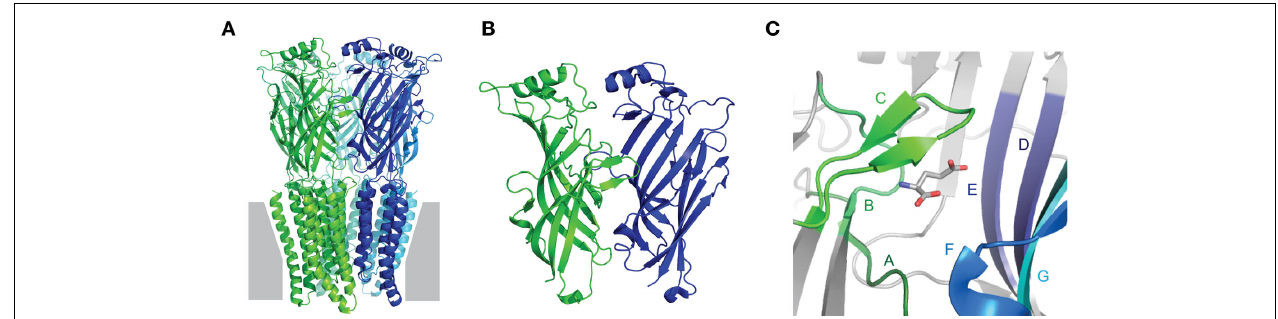
FIGURE 1 | Fundamental Cys-loop receptor architecture. (A) Pentameric Cys-loop receptor, viewed from within the membrane (gray) plane. Each of the five subunits is indicated by a different color and contains an extracellular N-terminal extracellular domain (ECD) consisting of two β -sheets and a membrane-spanning domain comprised of four α -helices. (B) Magnified view of the interface of adjacent ECDs: one subunit in green, one in blue. The